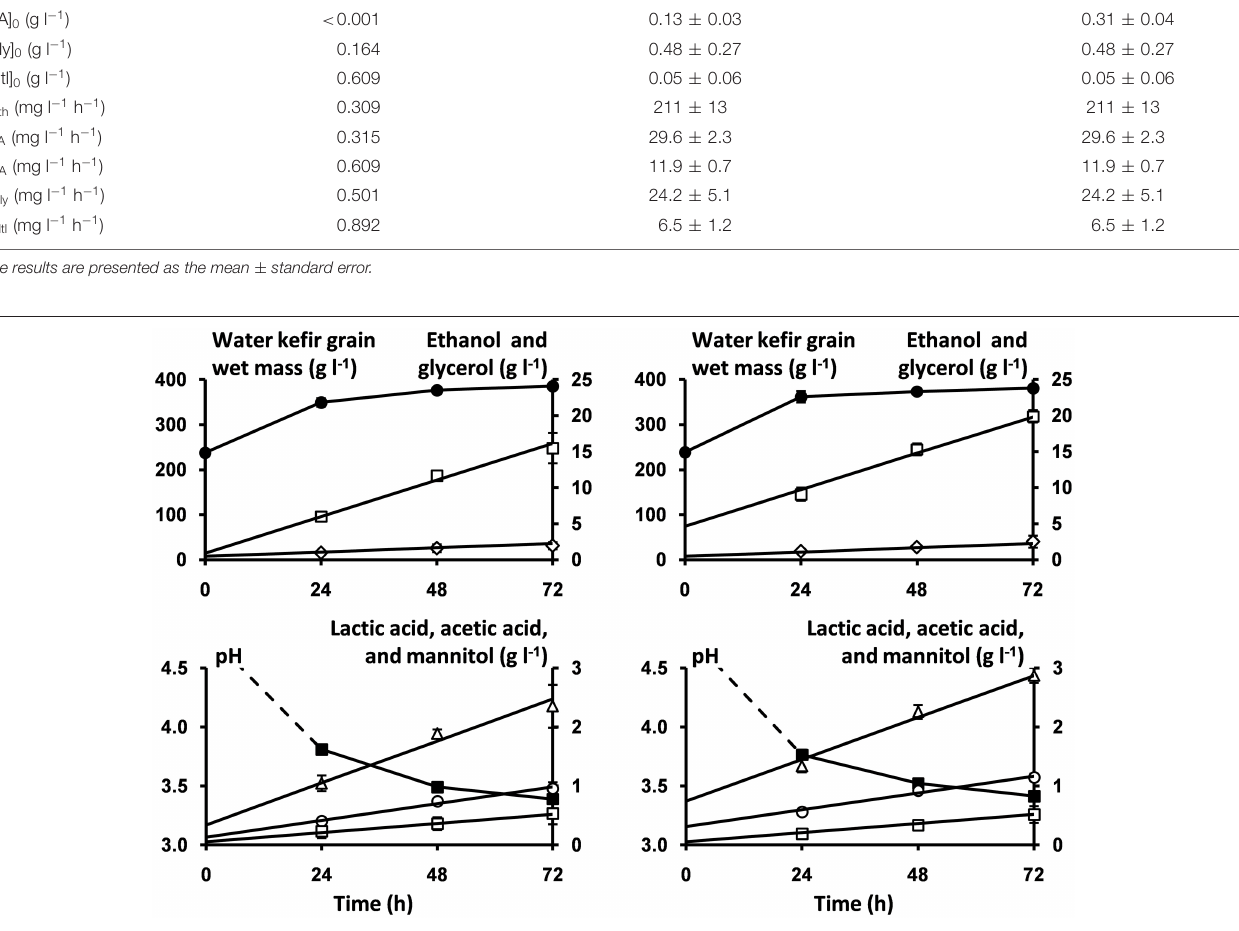
Short backslopping times resulted in low viable counts of AAB on the water kefir grains, which were even lower when the grains were rinsed during each backslopping step. Furthermore, rinsing of the grains during each backslopping step increased the relative abundance of Lenl . hilgardii and S . cerevisiae (both associated with the water kefir grains) and decreased the relative abundances of D . bruxellensis and Liql . nagelii (both associated with the water kefir liquors) (Laureys and De Vuyst, 2014,